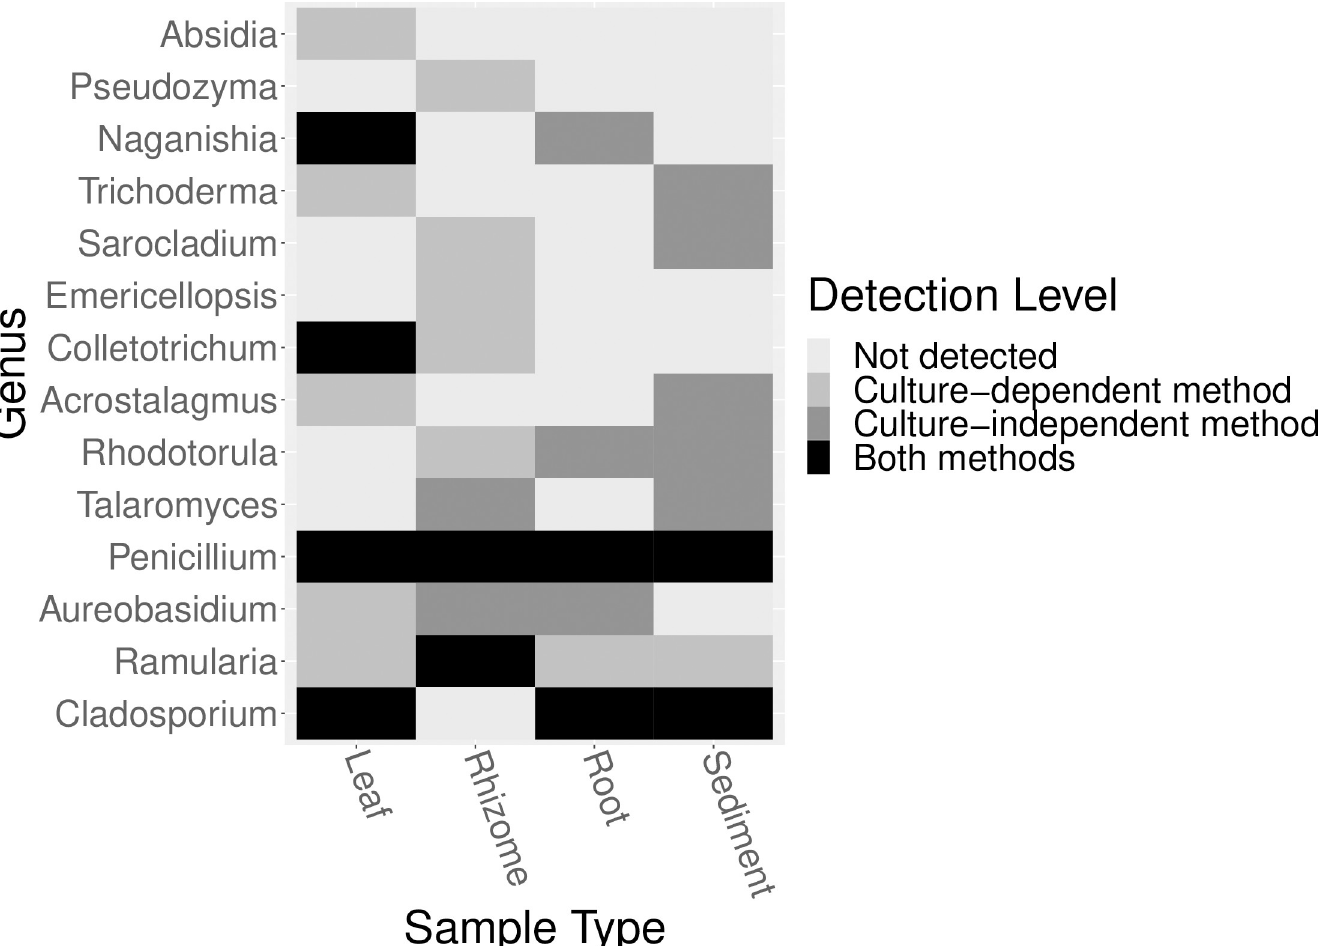
Fig 7. Comparison of the detection of a fungal genus across methods. A heatmap representing a comparison of the detection of the presence / absence of fungal genera isolated in this study (using a culture-dependent method) and fungal genera identified in high throughput sequencing data from Ettinger & Eisen [43] (using a culture-independent method). For each fungal genera, we visualize if it was not detected (light grey), detected using only the culture-dependent method (medium grey), detected using only the culture-independent method (dark grey) or detected by both methods (black) for each sample type / isolation source (leaf, root, rhizome,